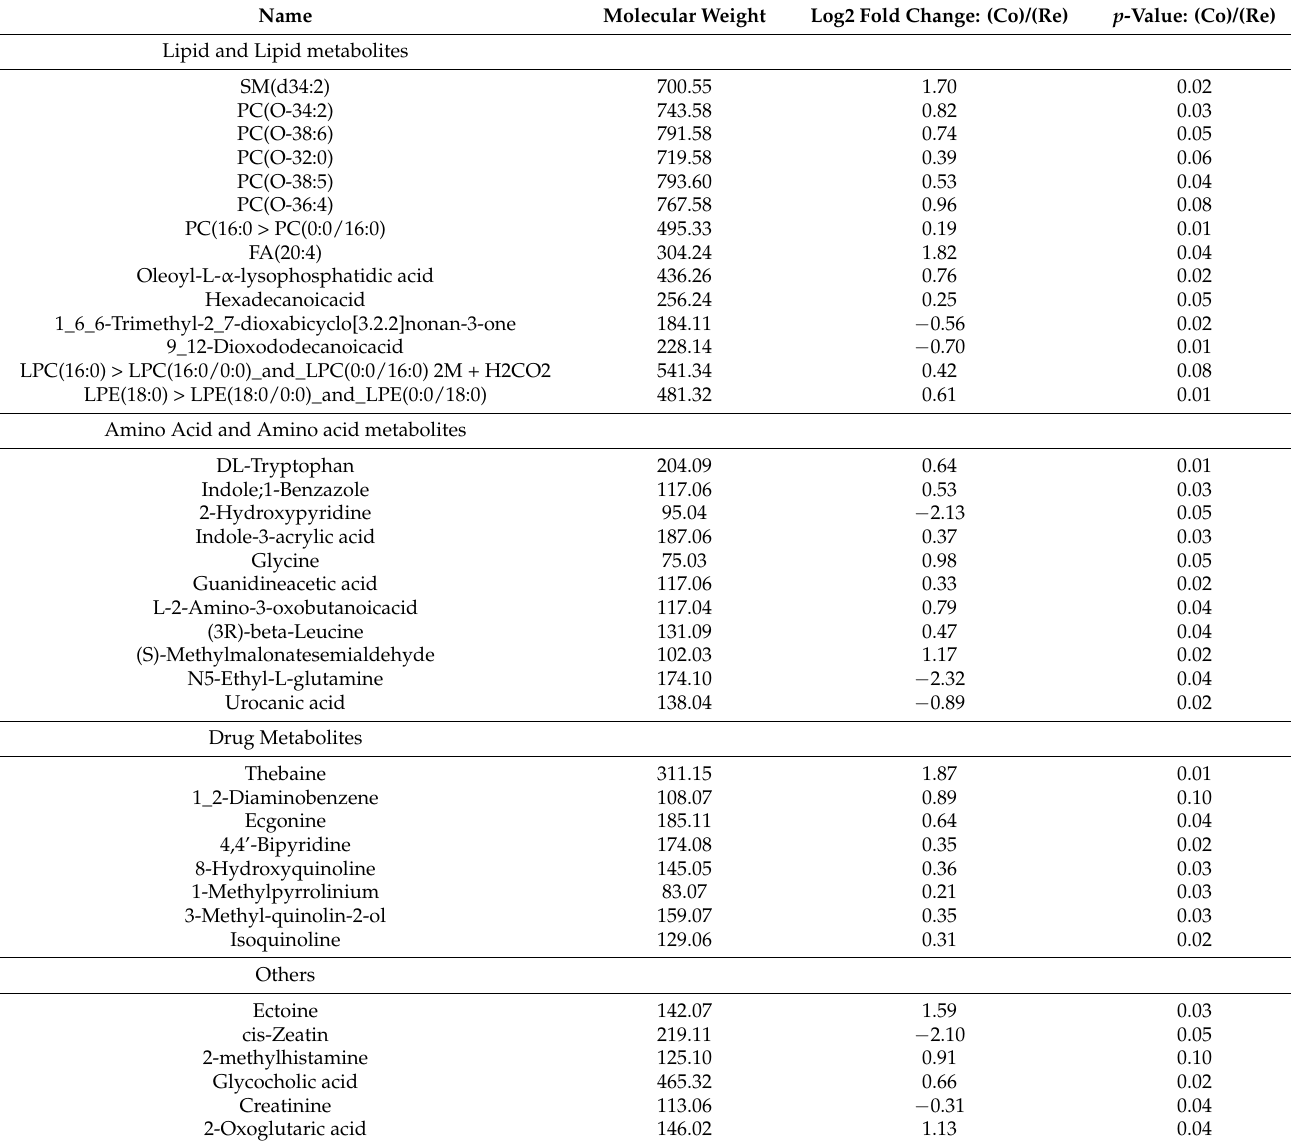
Table 1. Significantly altered metabolites in the serum of COVID-19-positive patients with observed fold changes.